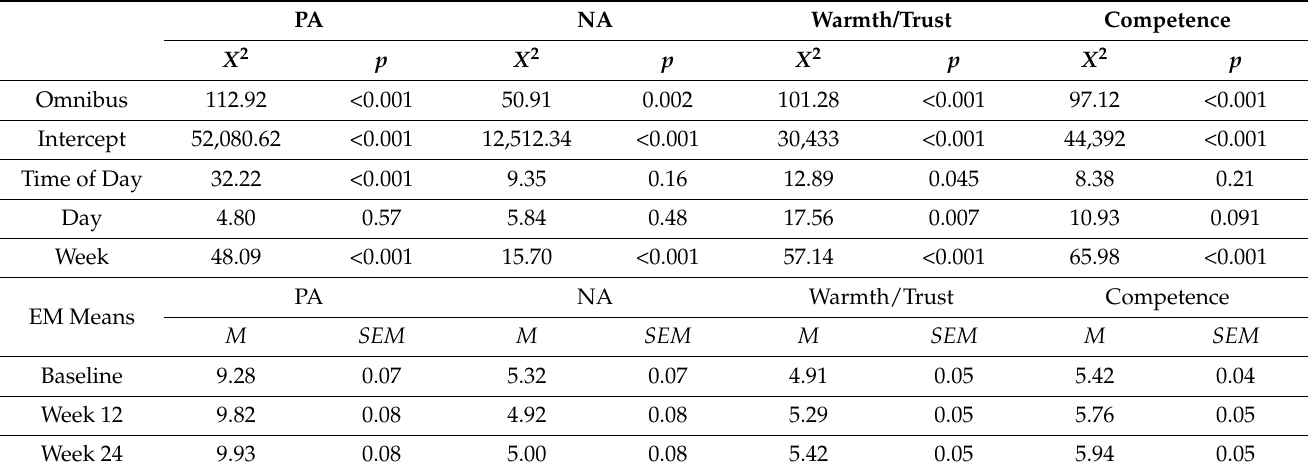
Table 3. Time Course of Affect States and Interaction